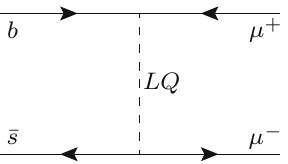
Fig. 1 Feynman diagram showing LQ mediation of an effective oper- ator contributing to NCBAs